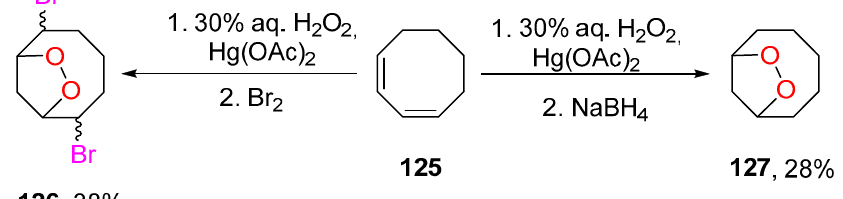
Scheme 43. Synthesis of bicyclic peroxides 126 and 127 .